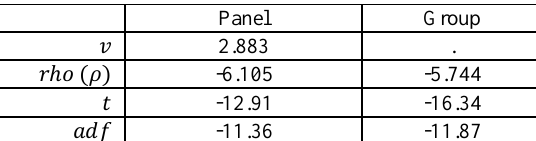
Table 6: Pedroni Cointegration test Outcomes Panel